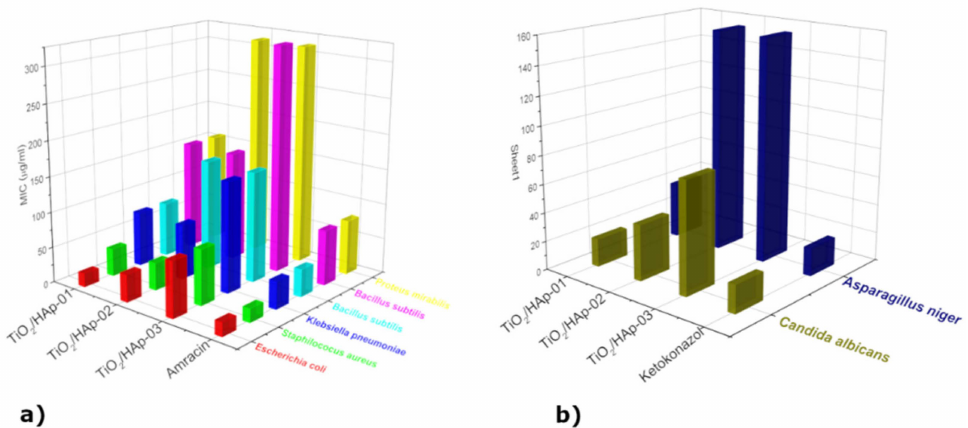
Figure 6. ( a ) MIC properties of TiO 2 /HAp-01, TiO 2 /HAp-02, and TiO 2 /HAp-03 in relation to Amracin; ( b ) MIC properties of TiO 2 /HAp-01, TiO 2 /HAp-02, and TiO 2 /HAp-03 materials in relation to